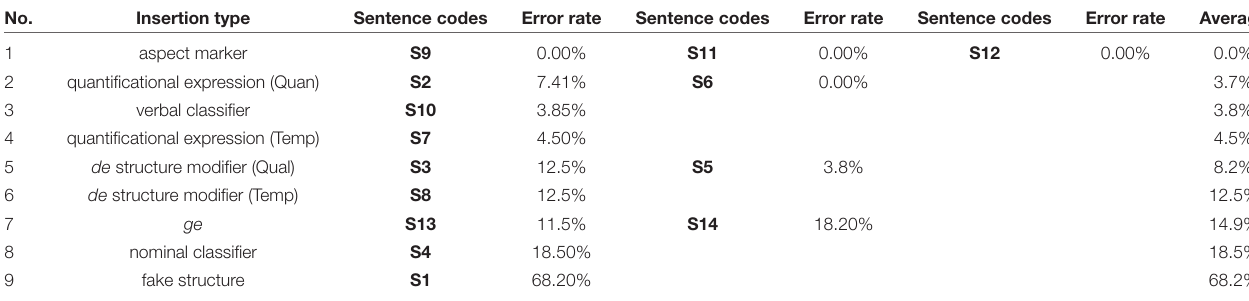
TABLE 7 | Error rate concerning the insertion